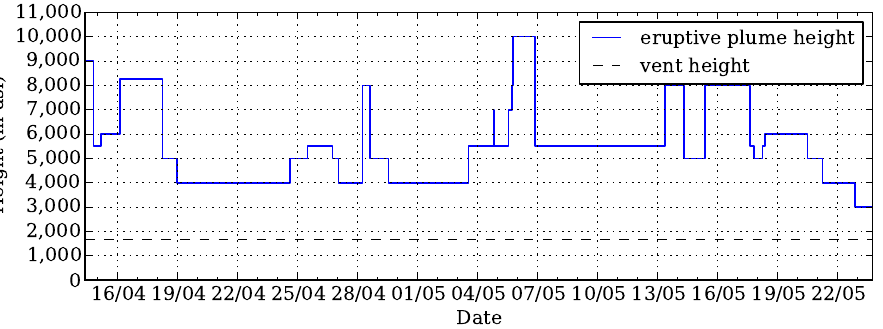
Figure 2. Eyjafjallajökull 2010 eruption plume rise heights estimated from local